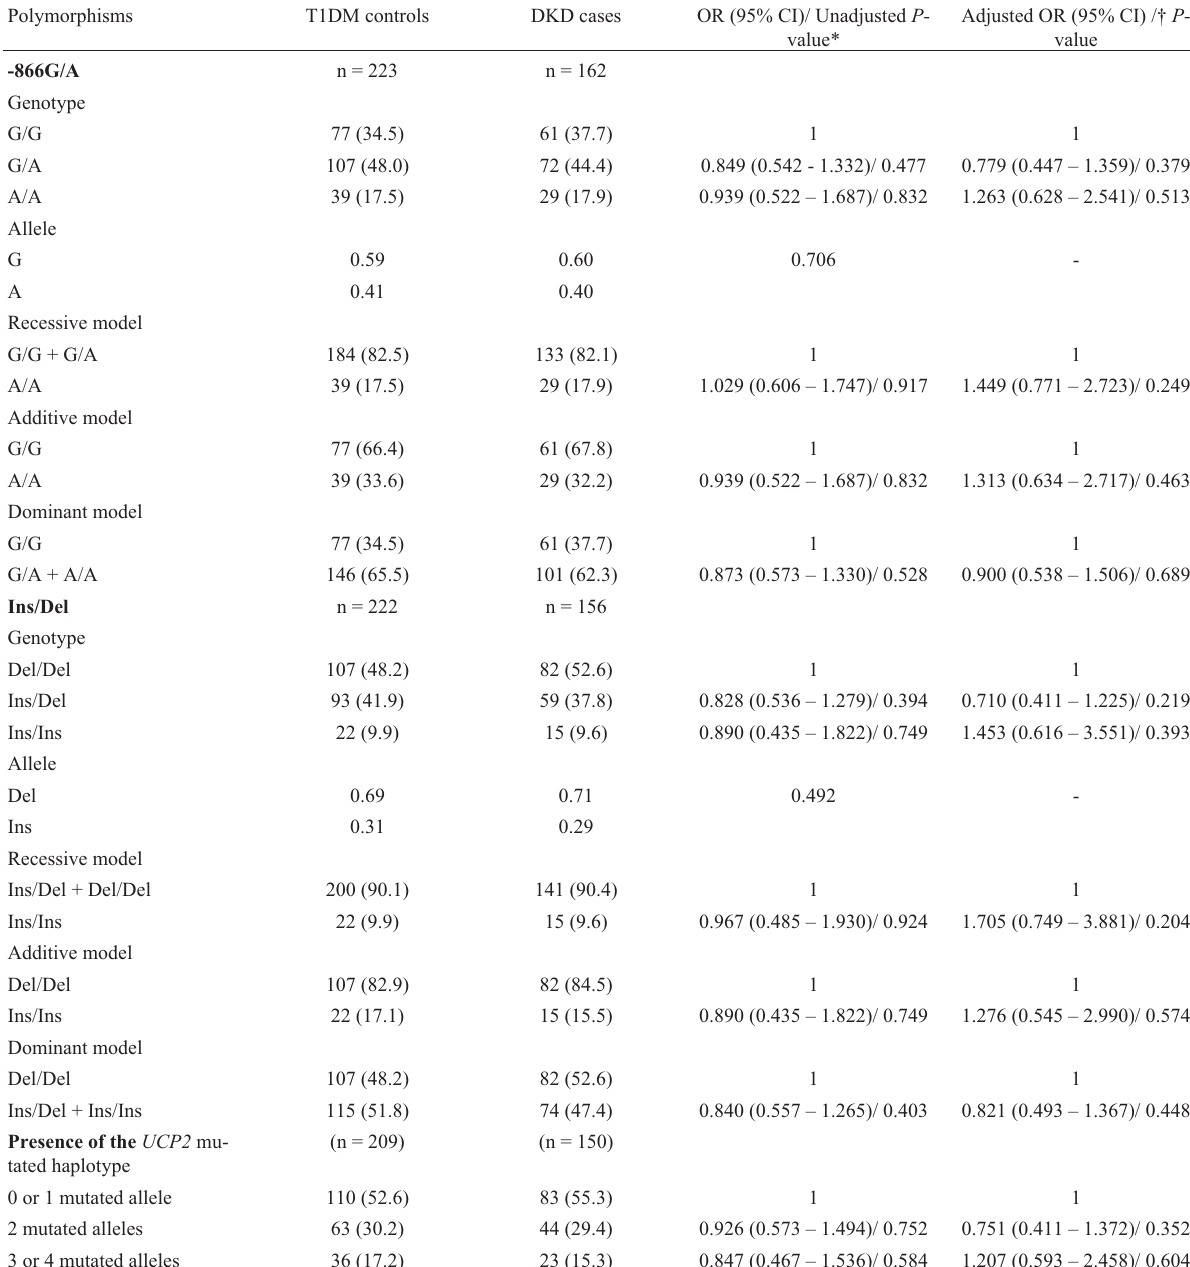
Table 2 - Genotype and allele frequencies of UCP2 -866G/A and Ins/Del polymorphisms in T1DM patients with UAE > 30 mg/24h (DKD cases) and in T1DM patients with UAE < 30 mg/24h (T1DM controls).